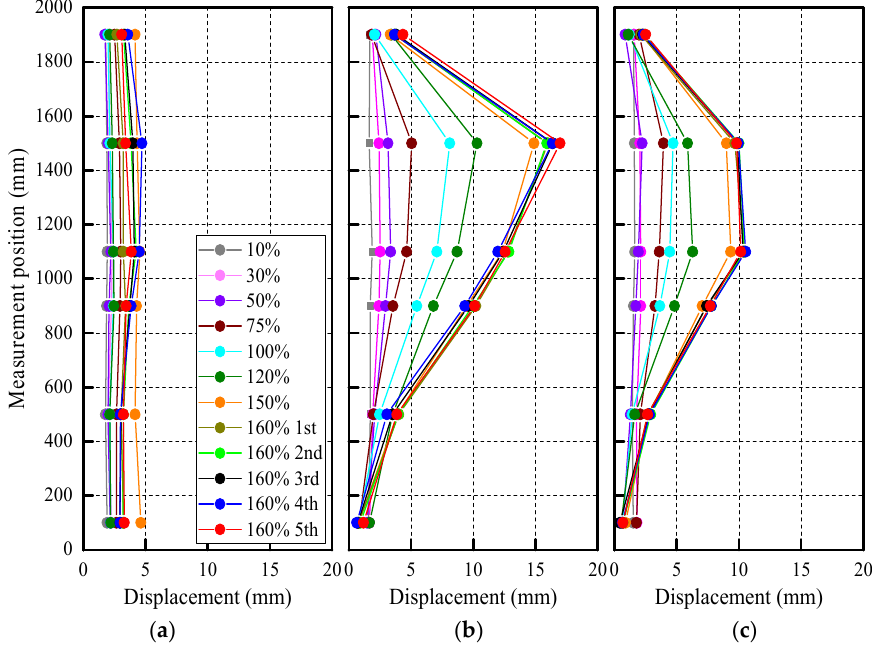
Figure 17. Displacement profiles: ( a ) Specimen CB; ( b ) Specimen HS; ( c ) Specimen PS.